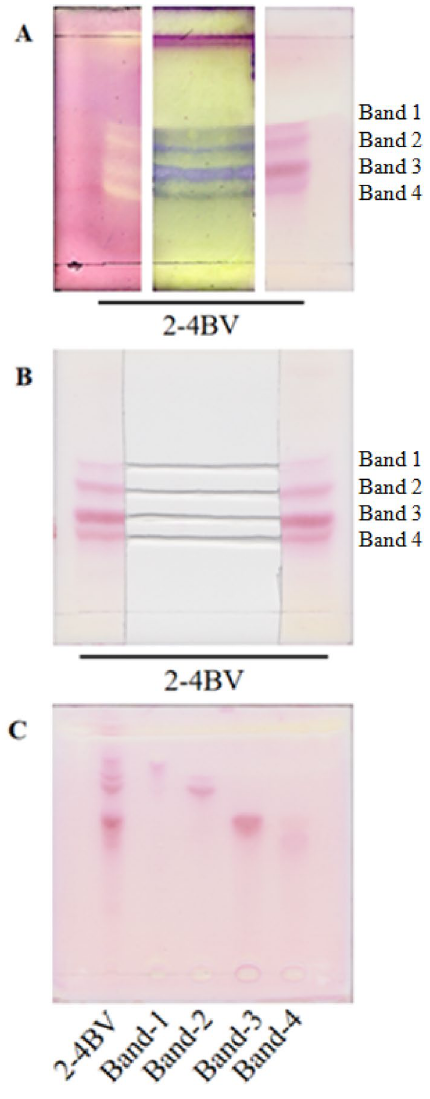
Figure 4. Purification of the active peptides by silica gel TLC in the 2–4 BV combinations from silica gel column chromatography based on TLC-bioautography. ( A ) TLC analyses of the active peptides. After developed, the TLC plate were cut into three parts and stained by (from left to right) DPPH, BCA solution and ninhydrin solution; ( B ) Separation of active peptides by scraping the active bands from the TLC plate. ( C ) TLC purified